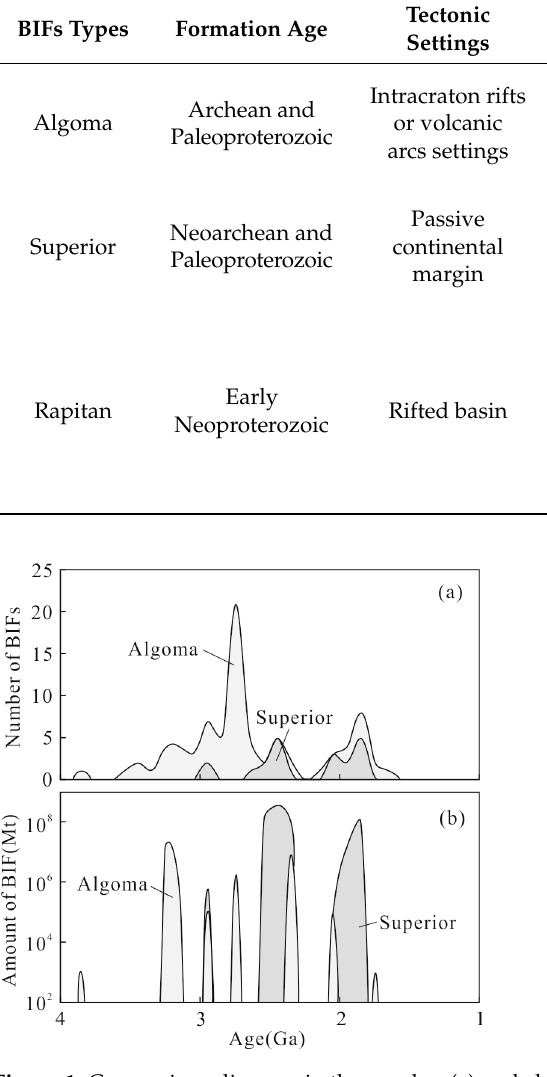
Table 1. Comparison of the three BIFs types.